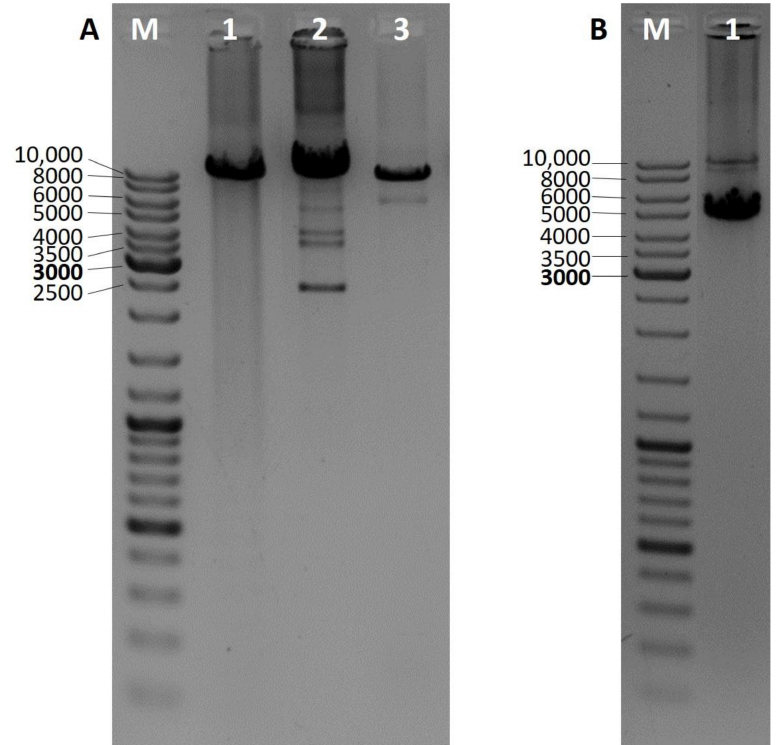
Figure 1. Long PCR 1% agarose gel electrophoresis results for the identification of mitochondrial DNA deletions in the so-called mtDNA major arc. Wild-type products are approximately 10 kb long, additional, shorter products indicate the presence of a mtDNA deletion. ( A ) M—DNA ladder, 1—no deletions, 2—multiple deletions, 3—single deletion; ( B ) M—DNA ladder, 1—two